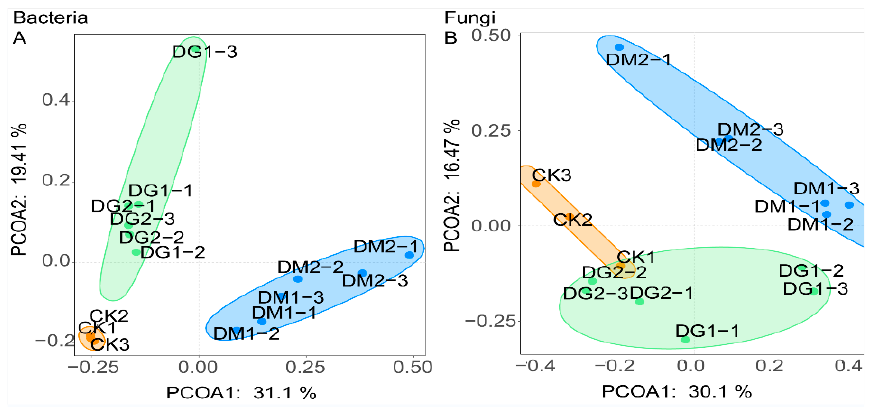
Figure 2. Communities of bacteria ( A ) and fungi ( B ) were analyzed using principal coordinate analysis (PCoA). Each dot stands for a sample, and variously colored dots denote various categories. Long-term fallow soils in CK, long-term continuous cropping of the volatile medicinal plant, perilla, in DG1, long-term continuous cropping of the volatile medicinal plant, mint, in DG2, long-term continuous cropping of the grain crop, corn, in DM1, and long-term continuous cropping of the grain crop, soybean, in DM2 are examples of long-term continuous-cropping soils.